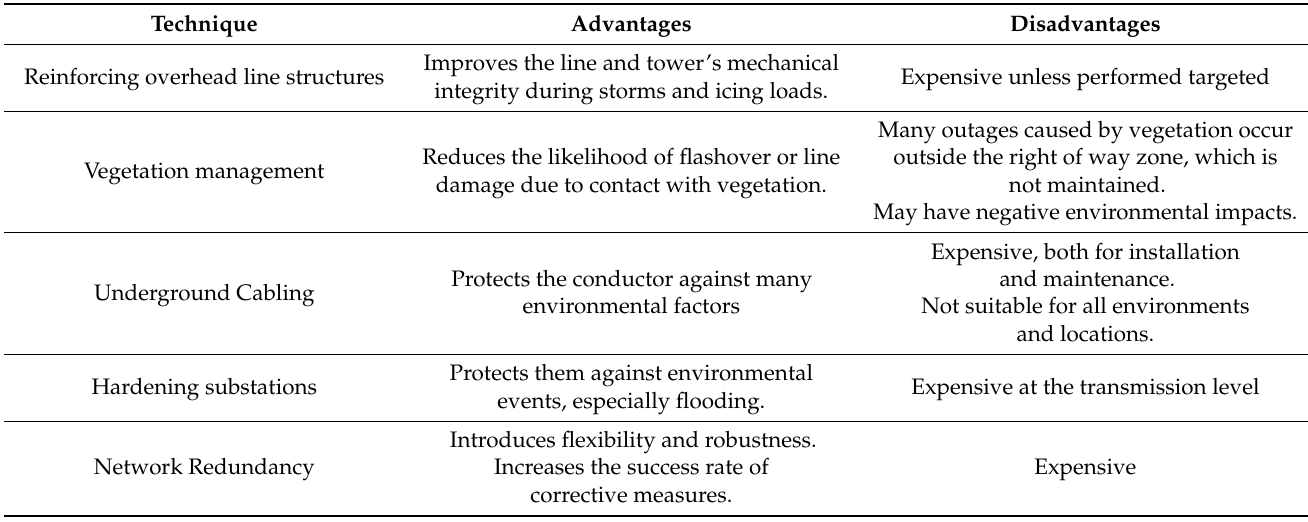
Table 3. Comparison of various infrastructure resilience